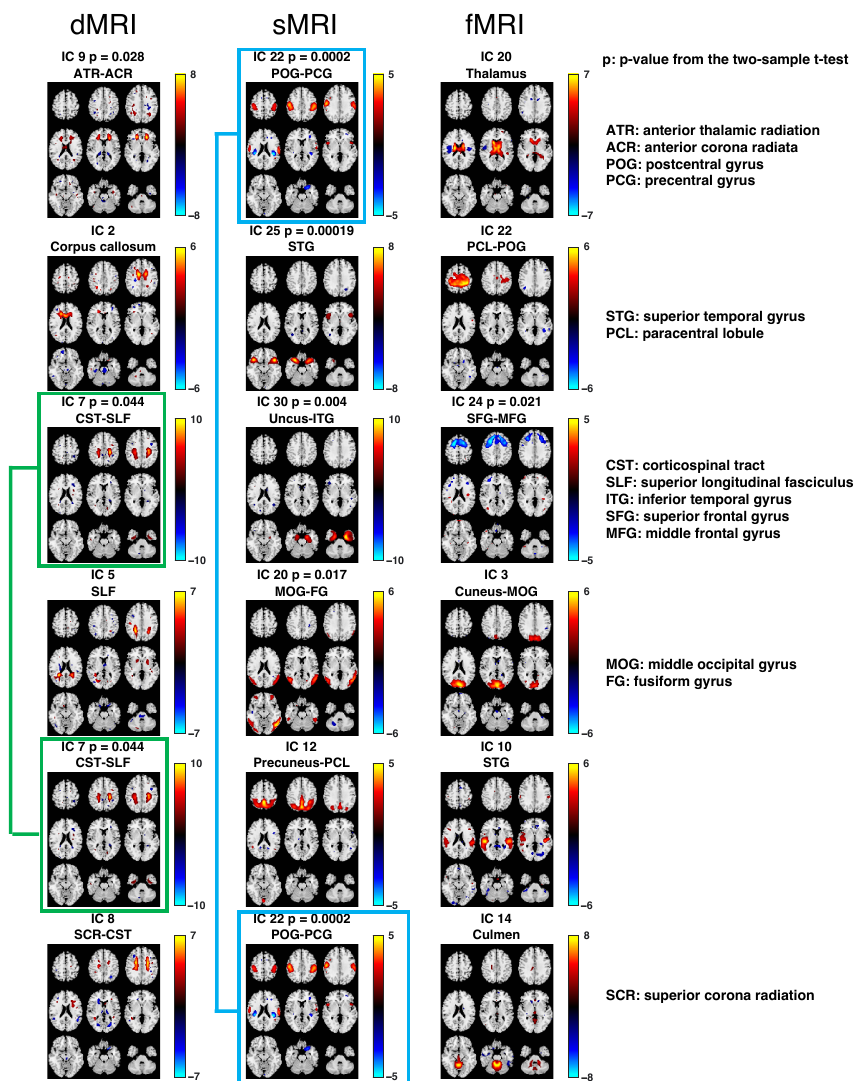
Figure 7. Summary of the six IC linked triplets. The spatial maps of all ICs were converted to Z -scores and thresholded by Z 2. Each row shows the three associated ICs from dMRI, sMRI, | | ≥ and fMRI, respectively. The abbreviations of brain regions identified by ICs are shown above the spatial maps. If one IC shows a statistically significant activation between HCs and SZs ( p < 0.05; t -test), the p value would be shown above the map, where the red color indicates higher activation in HCs than patients and the blue color indicates lower activation in HCs than patients. Note that the IC 7 (green frame) from dMRI is associated with two ICs from sMRI and two ICs from fMRI. IC 22 (blue frame) from sMRI is associated with two ICs from dMRI and two ICs from